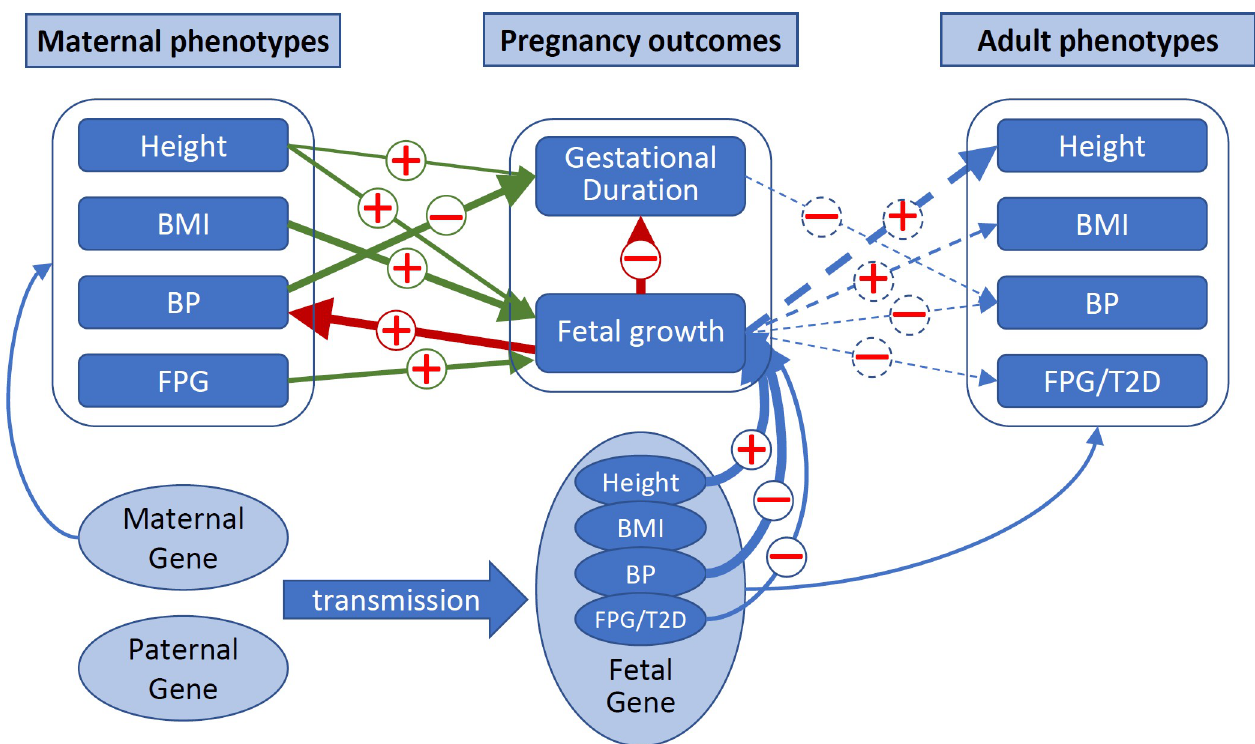
Fig 6. Estimated maternal and fetal genetic effects underlying the associations between maternal phenotypes and pregnancy outcomes and their associations with adult phenotypes. Blue arrows: maternal or fetal genetic effects. Green arrows: maternal causal effects. Red arrows: “fetal drive.” Dashed arrows: genetically confounded associations between birth outcomes and late adult phenotypes due to shared genetics. The widths of the arrows were approximately proportional to the estimated effect sizes evaluated by per-SD changes, which can be found in S13 Table (maternal causal effect), Tables 3 and 4 (fetal drive), and Fig 4 (genetically confounded associations). BMI, body mass index; BP, blood pressure; FPG, fasting plasma glucose; SD, standard deviation; T2D, type 2 diabetes